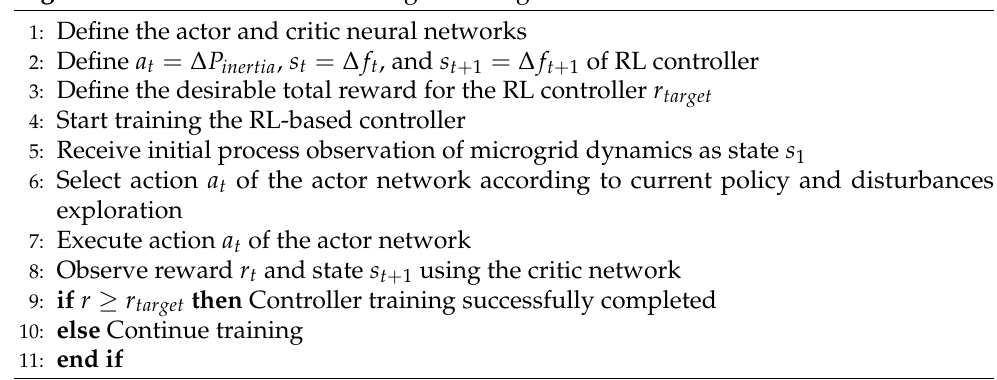
Algorithm 3 Reinforcement-learning-based